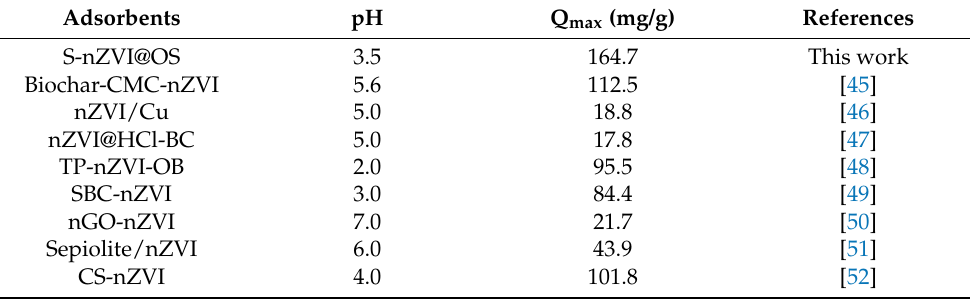
Table 3. Comparison of Cr (VI) removal by various modified nZVI Table 2. Isotherm parameters of S-nZVI@OS removal of Cr (VI).